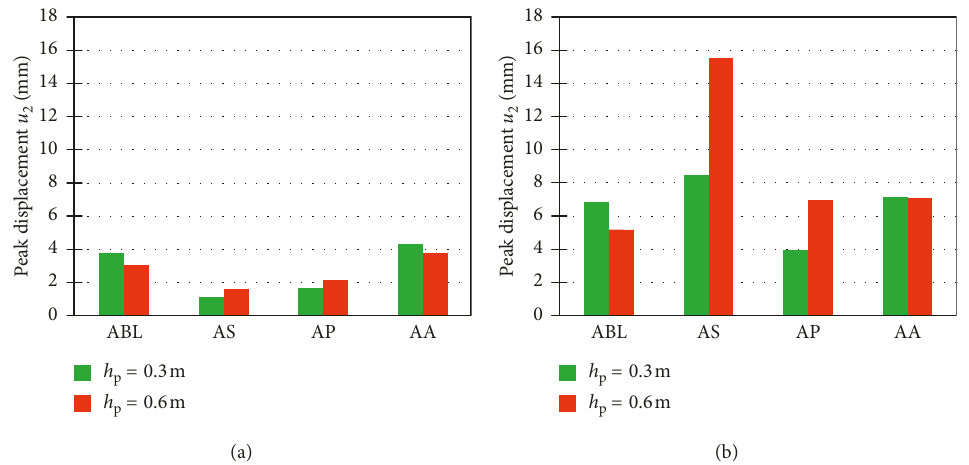
Figure 11: The effect of aseismic layer thickness on peak horizontal displacement u